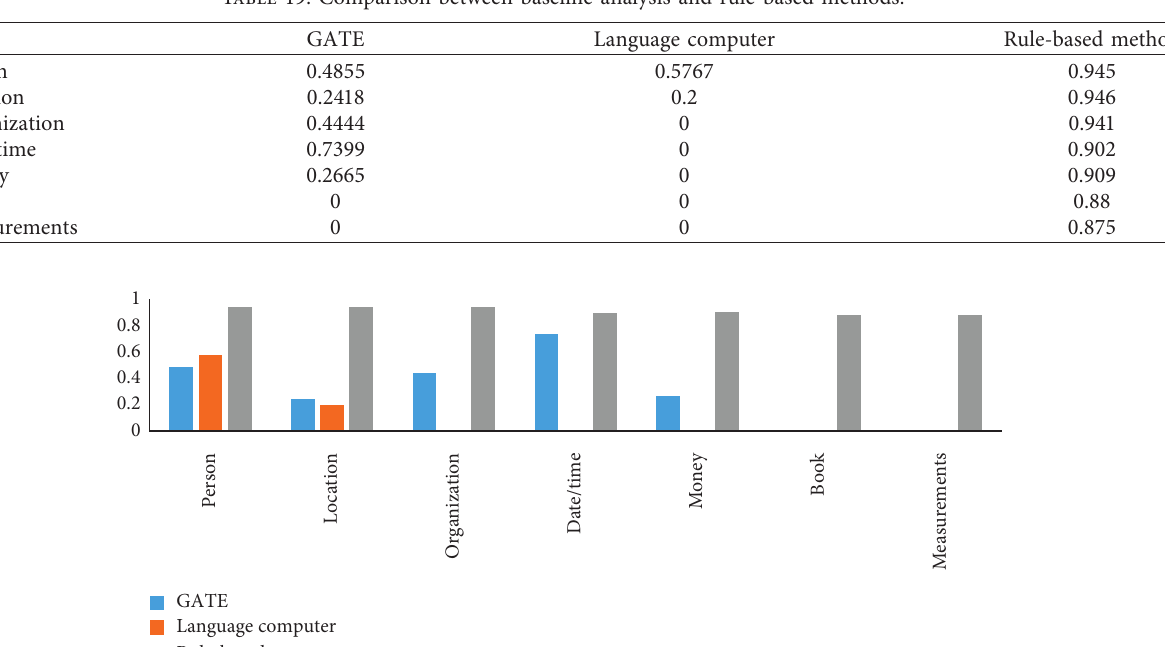
Table 19: Comparison between baseline analysis and rule-based methods.